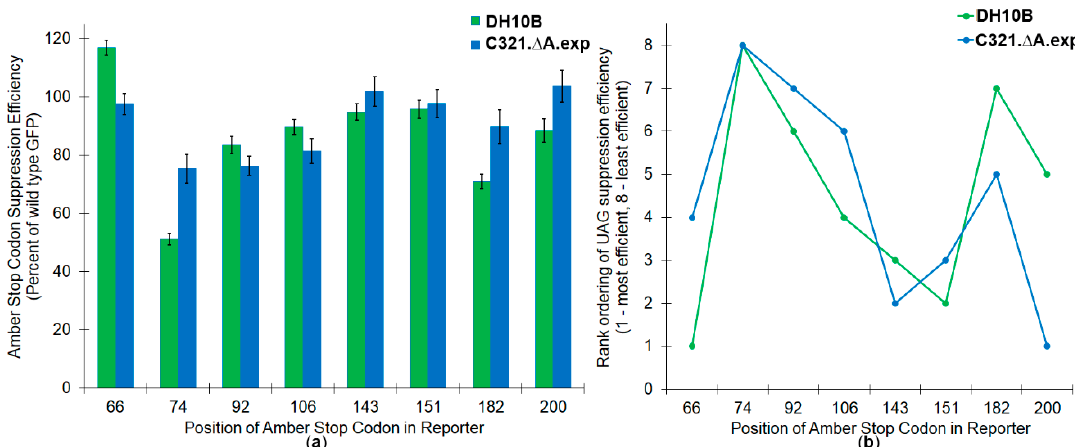
Figure 1. Side by side comparison of amber stop codon reassignment in two Eschericia coli strains. ( a ) Reassignment efficiencies as a percentage of wild type GFP at each of the eight single site UAG variants. ( b ) Rank ordering of suppression efficiencies of eight single site UAG positions from most efficient (placed at #1) to least efficient (placed at #8) in two E. coli strains. Green bars and dots represent data measured in DH10B cells; blue bars and dots represent data measured in C321. Δ A.exp.